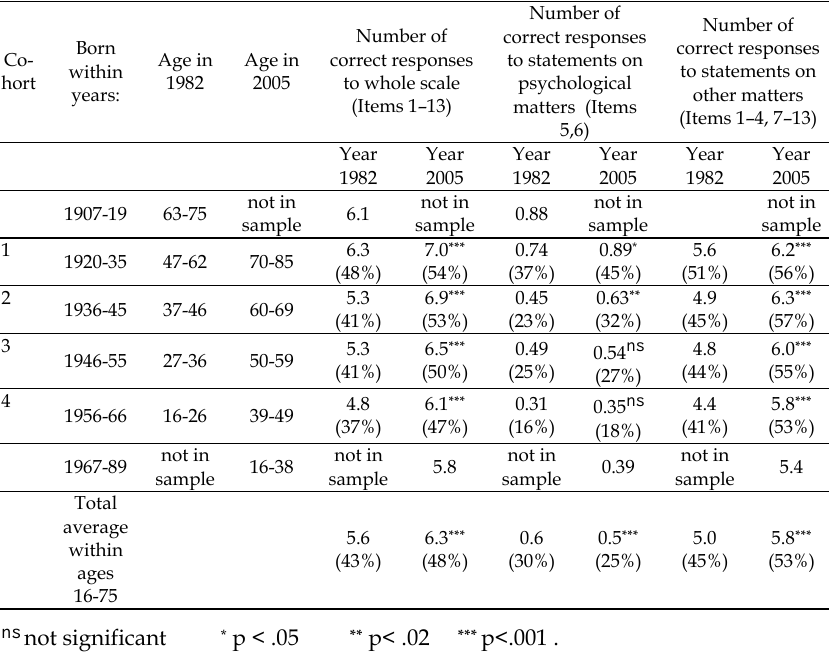
Table 6 . Knowledge development in four cohort groups, and whole data sets. Average number of correct responses. Percentage correct responses in